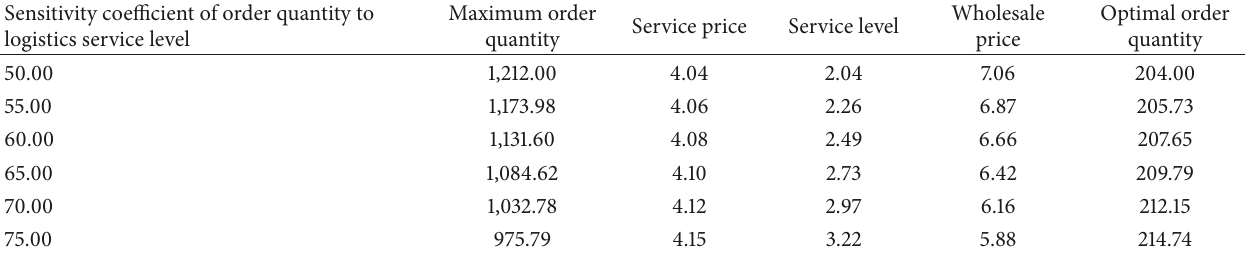
Table 2: The effect of the sensitivity coefficient of the order quantity to the logistics service level on the supply chain members’ decisions. Sensitivity coefficient of order quantity to